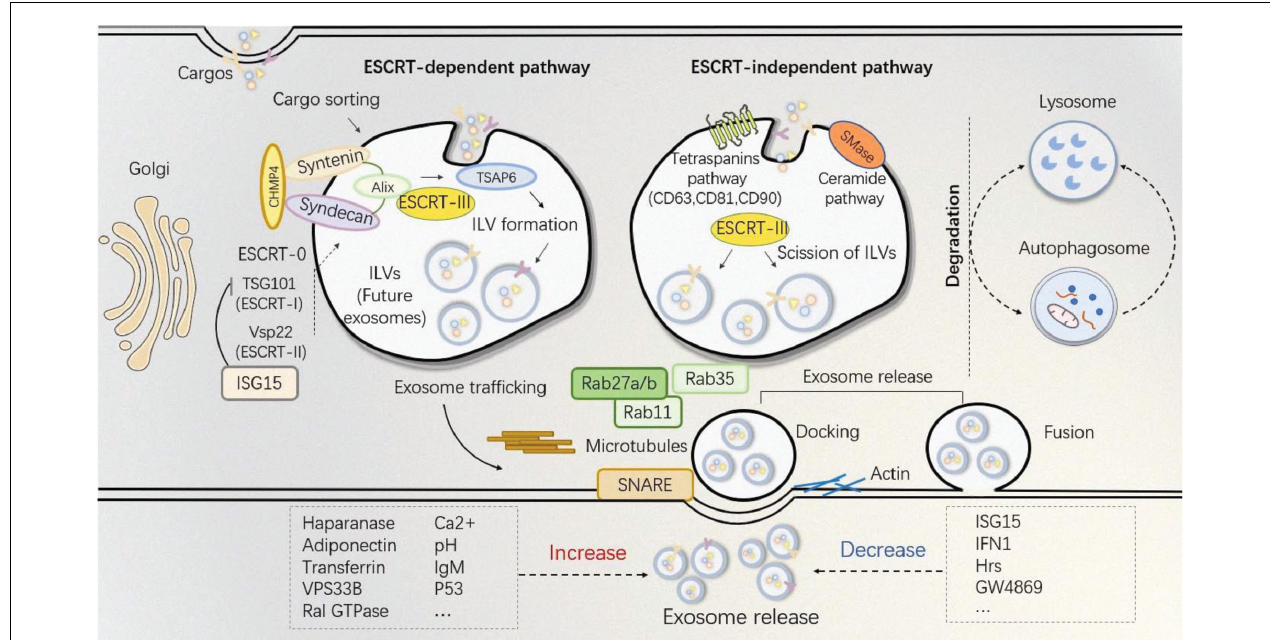
FIGURE 1 | Exosomes biogenesis and release. Cytomembrane lipids and membrane-associated proteins are clustered in micro-domains for MVB formation. Soluble components, such as cytosolic proteins and RNAs are recruited for exosome cargo sorting. Other cargos can be specifically sorted via the trans-Golgi network into MVBs. Mechanisms of exosome biogenesis are well-accepted by different pathways, basically distinguished as ESCRT-dependent and ESCRT-independent manner. Notably, ESCRT-III is required for the final formation of the ILVs, while cargo sorting and membrane budding can be regulated by either pathways. MVBs will either undergo degradation by lysosomes and autophagosome (finally lysosomes) or to dock or fuse with the cytomembrane. Docking and fusion are the two final processes required for exosome release whereby Rab family members, SNARE, as well as actin are involved. Treatments such as haparanase, adiponection, transferrin, VPS33B, Ral GTPase, Ca 2 + , IgM, pH, p53 will help to increase exosome production while ISG15, IFN1, Hrs, GW4869 can block exosome secretion by different